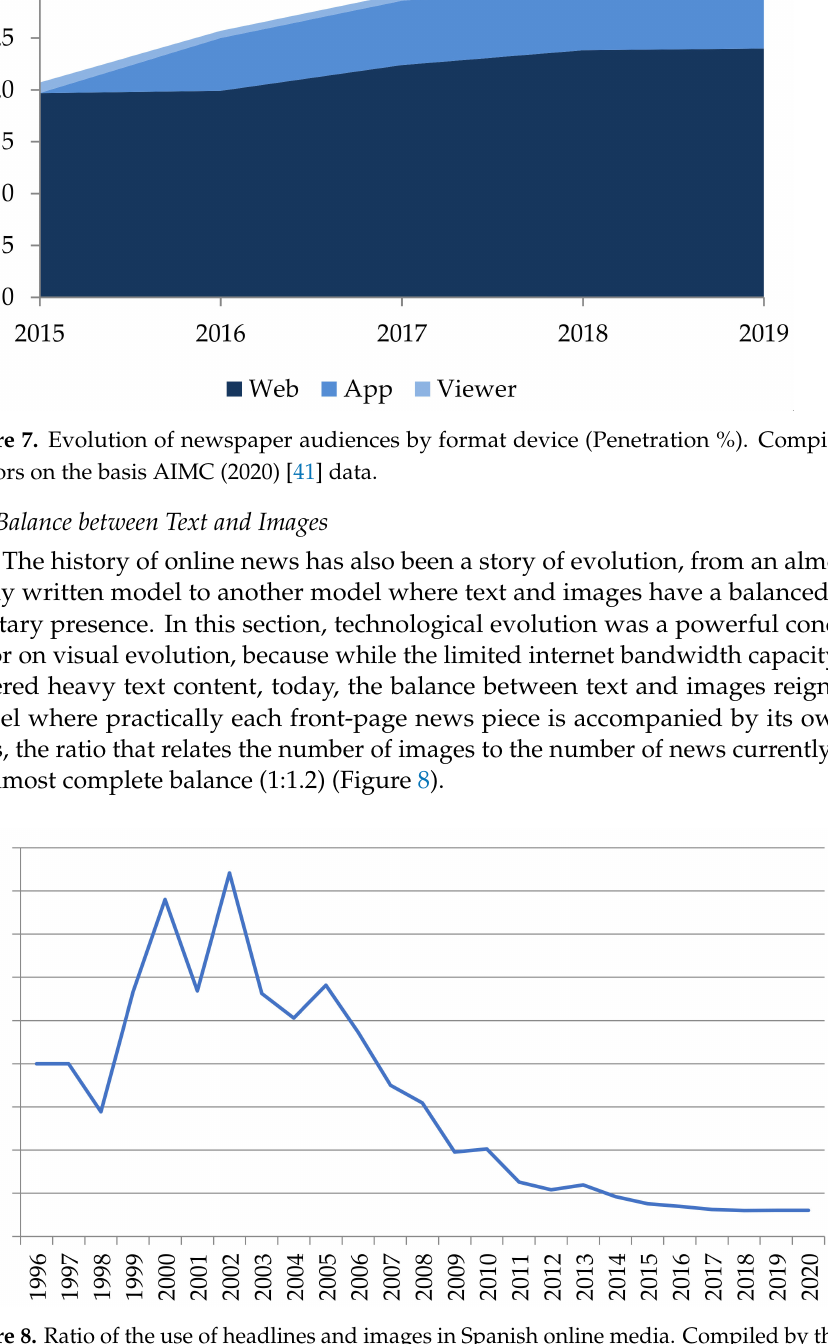
Figure 8. Ratio of the use of headlines and images in Spanish online media. Compiled by the